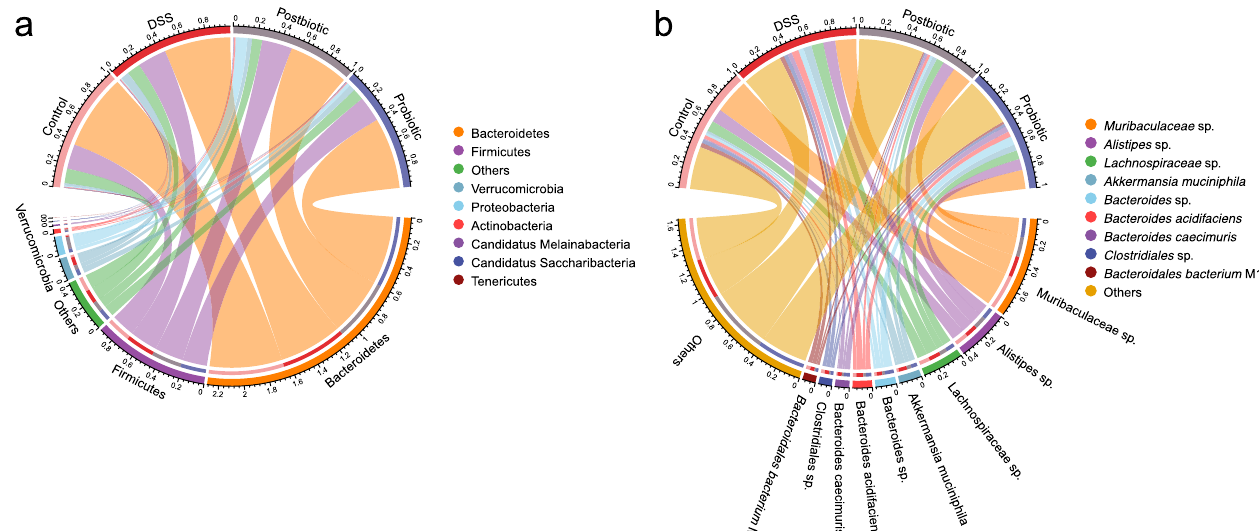
Fig. 3 Compositional differences in fecal microbiota among Control, DSS, Postbiotic, and Probiotic groups. Chord diagram showing phylum-level ( a ) and species-level ( b ) of the fecal microbiota. The upper half circle represents the four treatment groups, while the lower half circle represents the overall composition of fecal microbiota across all groups. DSS, dextran sulfate sodium.